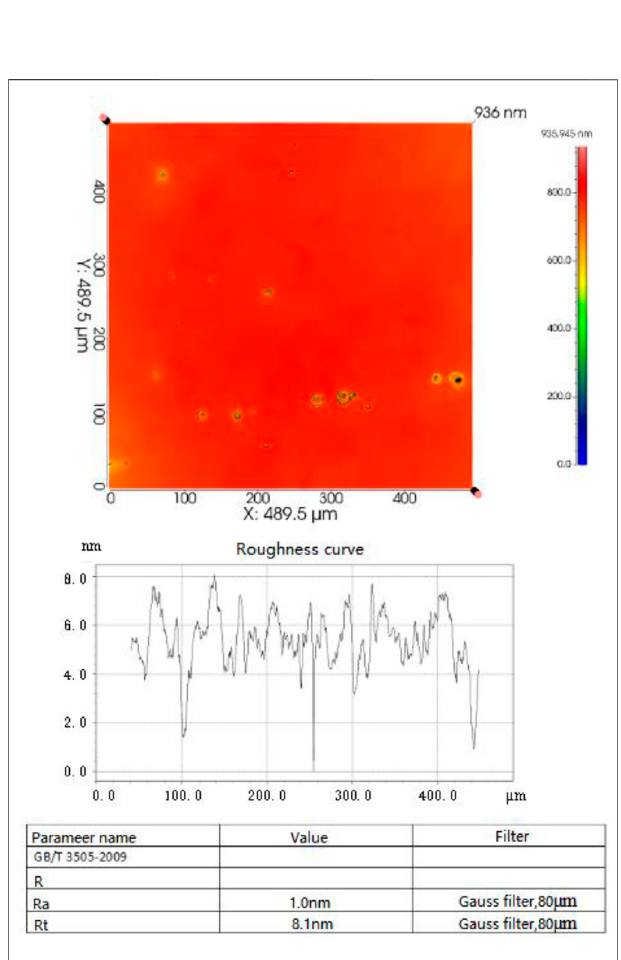
FIGURE 4 | Surface morphology of the Q235 steel sample after the lapping and polishing processes at r p = 108 r/min, P = 33 N, Q a = 20 ml/min, and t = 3